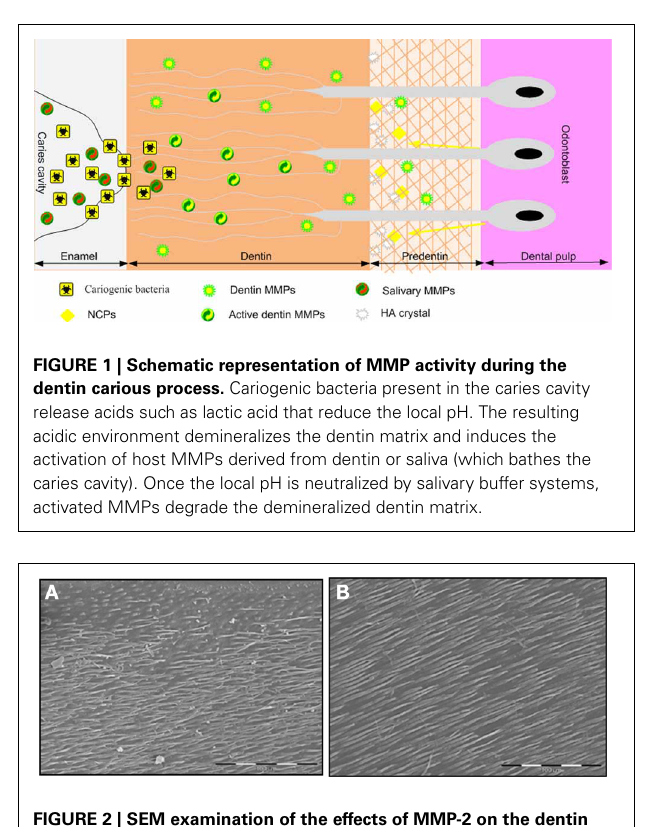
FIGURE 2 | SEM examination of the effects of MMP-2 on the dentin matrix through low viscosity resin replicas. (A) Standardized human dentin cubes were treated for 24h with 0.5M lactic (pH 4.8) and resin penetration in demineralized dentin was observed by resin replicas. The low viscosity resin penetrates in the main dentin tubules. (B) The treatment of demineralized dentin cubes by activated recombinant MMP-2 shows a deeper resin penetration into the main dentin tubules, suggesting increased dentin matrix degradation. Bar =